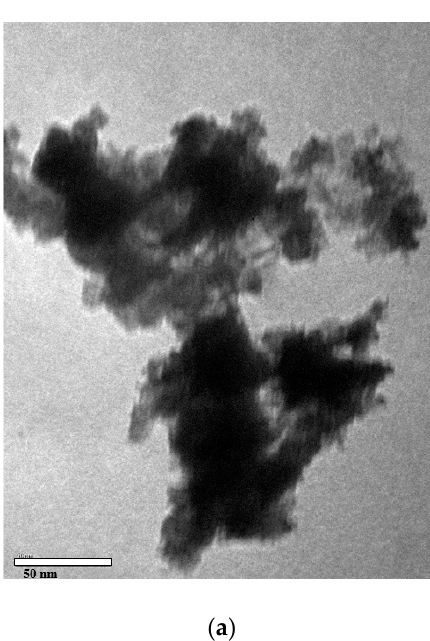
Figure 3. SEM photograph of ( a ) catalyst 1; ( b ) catalyst 1 (treated in basic solution).